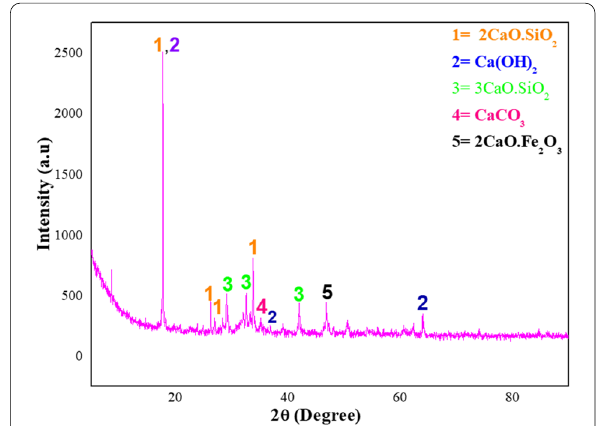
Fig. 6 XRD analysis of LD slag (Singh & Vashistha,